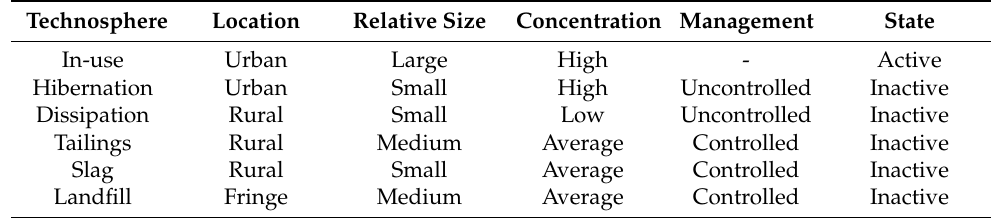
Table 1. Features of the technosphere (primarily relevant to copper and iron)